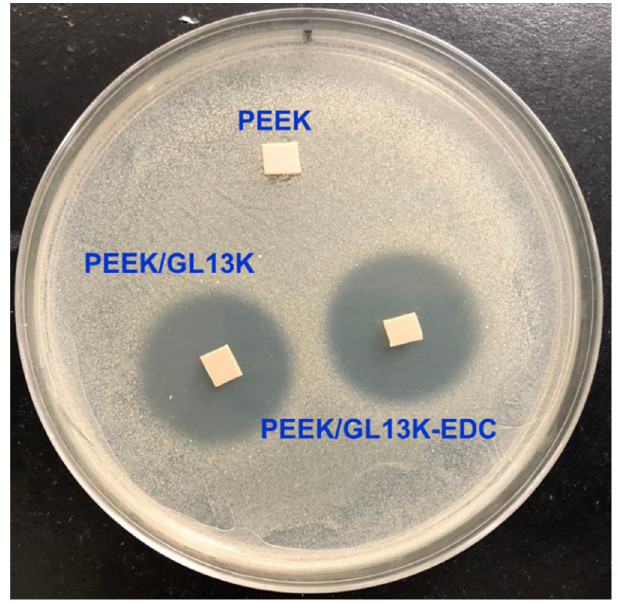
Figure 5. Photographic image and the zone of inhibition against S. aureus using PEEK, PEEK/GL13K, and PEEK/GL13K-EDC samples.